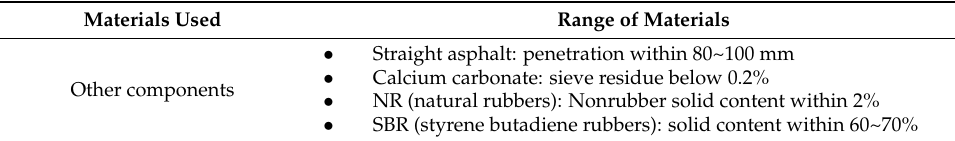
Table 3. Raw material component ratio of W-SPRG (%).